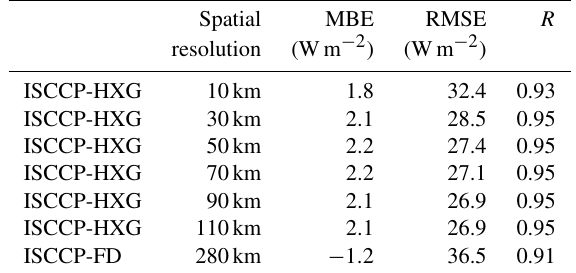
Table 3. Effect of spatial resolution on accuracy of our estimated daily SSR compared to observations at 90 CMA radiation stations. A comparison with daily SSR of ISCCP-FD is also shown.